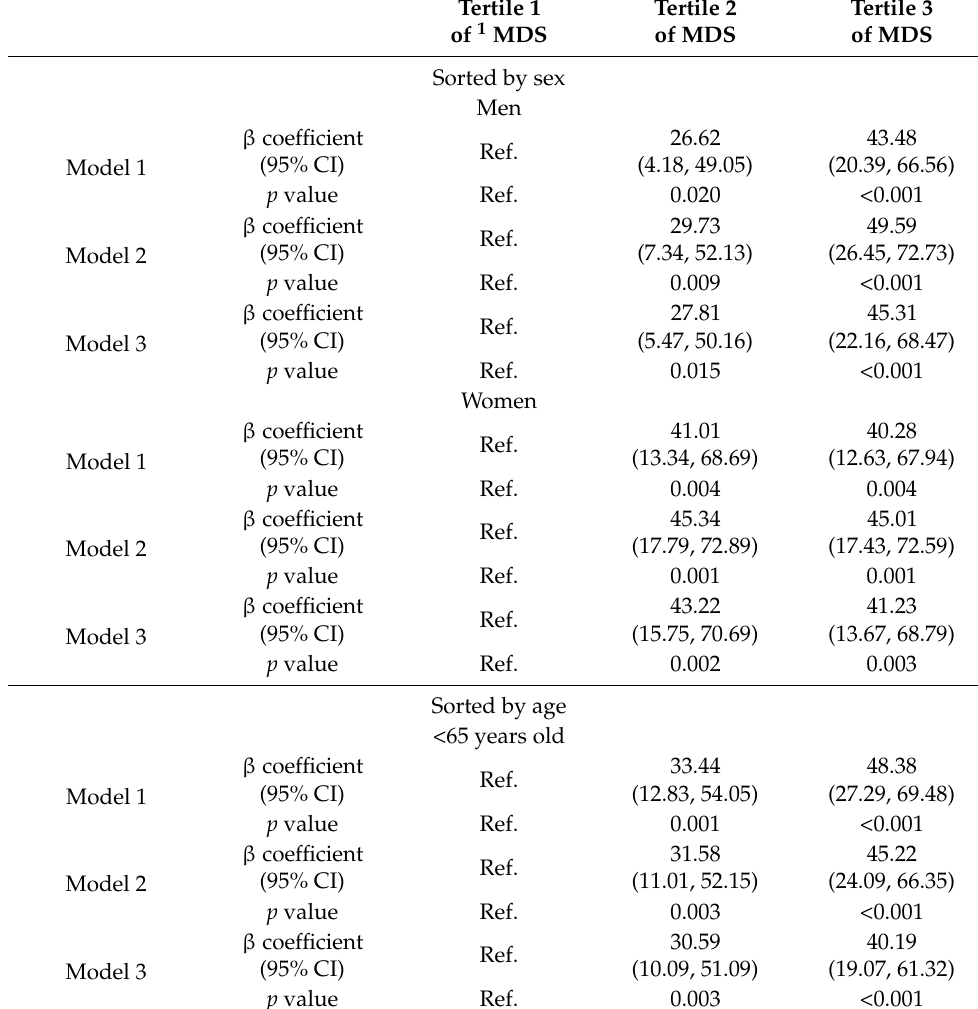
Table 4. Associations across tertiles of Mediterranean diet score and serum Klotho levels in subgroups.